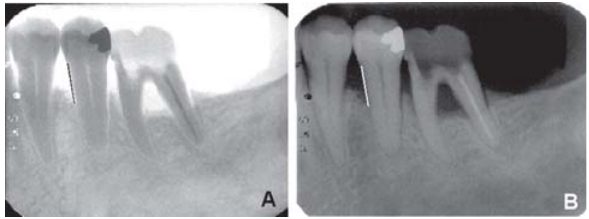
FIGURE 1- Digitized radiographic images: inverted (A) and unprocessed (B) showing the bone loss measurements (black and white lines), from the cement enamel junction to the most apical extension of the bone loss